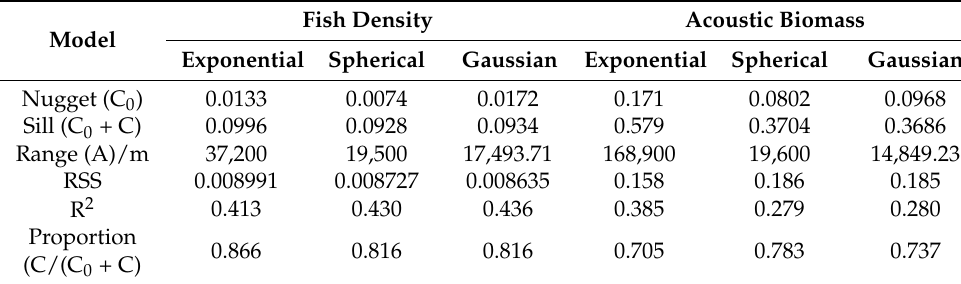
Table 5. Goodness-of fit measures for geostatistical model.